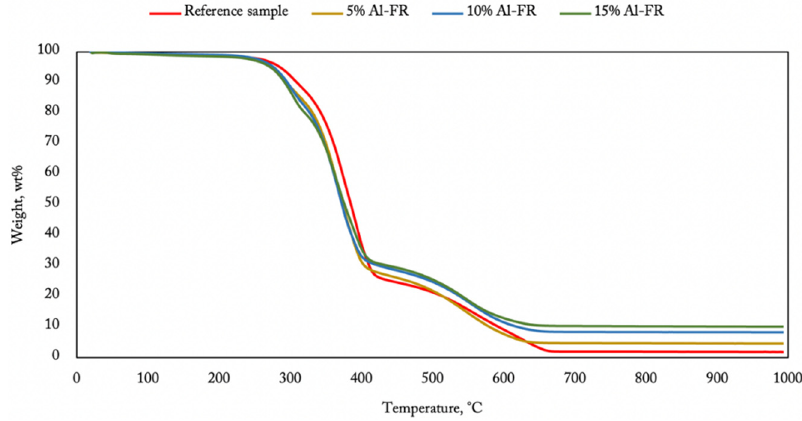
7 of 12 Figure 6. SEM of elastomeric hybrids based on polyurea: ( a ) reference sample; ( b ) 10% Al-FR; ( c ) 10% P-FR; ( d ) 10% P/Cl-FR. 3.3. Thermal Decomposition Figures 7–9 show the TGA results obtained for membranes containing flame retardants in the air atmosphere. It is easy to observe (Figure 7) how the inorganic compound content changes the terminal mass of the burnt sample. It is worth noticing